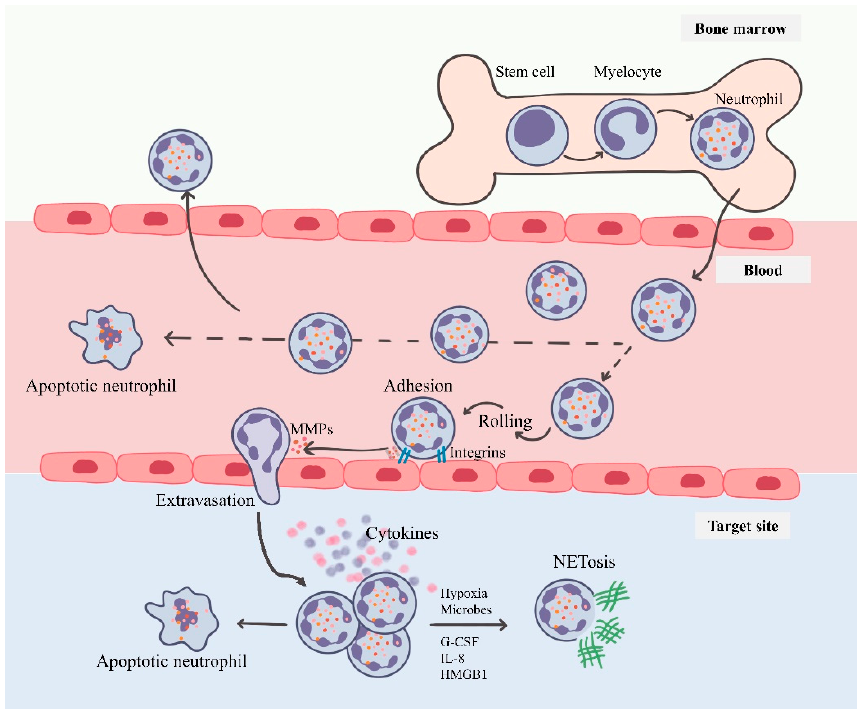
Figure 1. Neutrophils—from bone marrow to target site: The neutrophils originate from the bone marrow with a short lifespan in circulation. They migrate towards the chemokines following a rolling–tethering–extravasation step. These activated neutrophils both target the infectious agent and further undergo programmed cell death or under tumor-like microenvironment (cancer cells, hypoxia, stroma cell signals) are triggered to undergo NETosis.